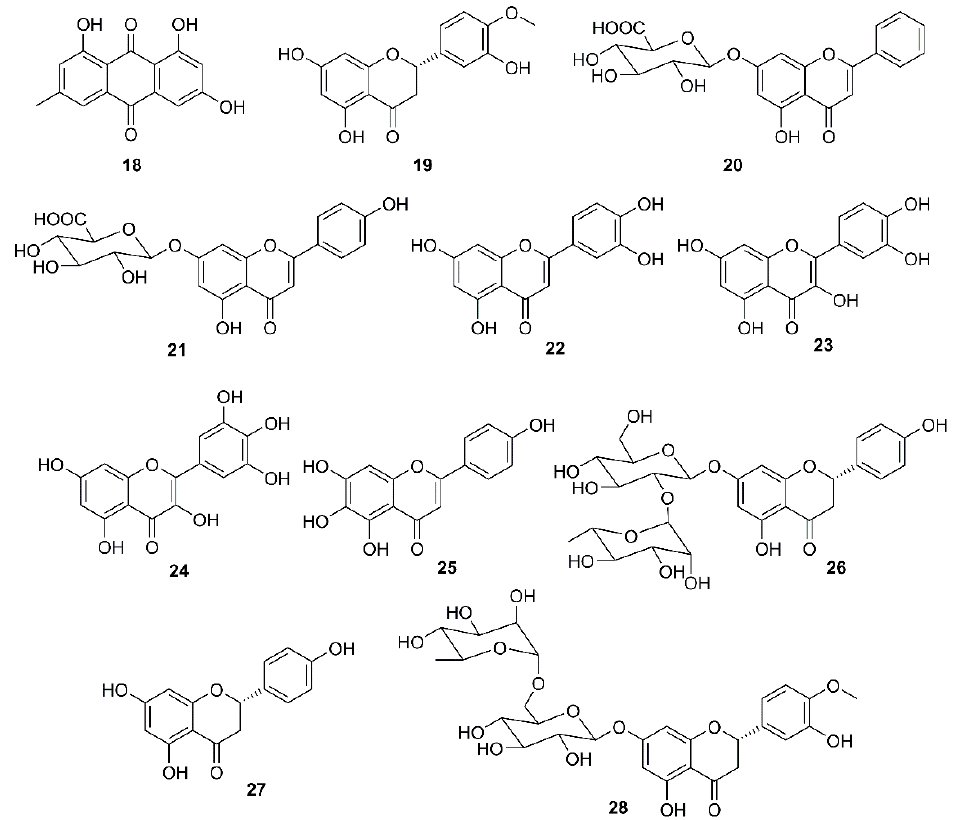
Figure 5. Structures of emodin ( 18 ), flavonoids, and flavonoids glycosides 19 – 28 .